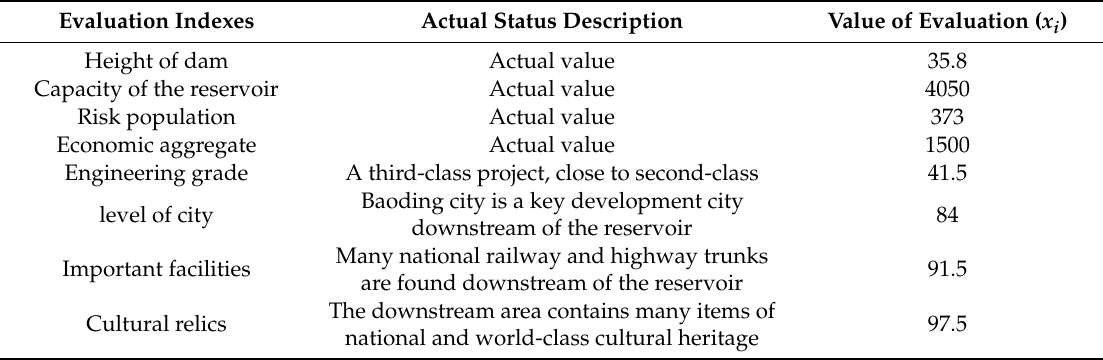
Table 5. Values of various indexes of the dam break social impact assessment for the Liujiatai